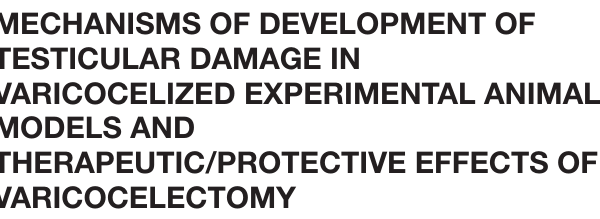
months or longer between varicocele repair and sperm retrieval surgical procedure is recommended